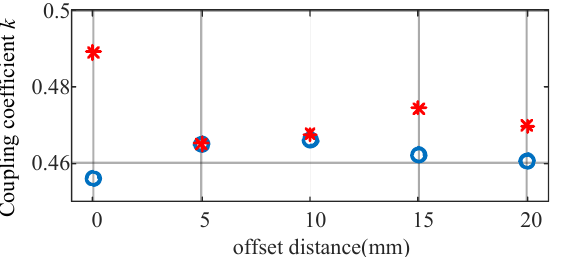
Figure 32. Coupling coefficient curves with the two structures and different offsets of the second-